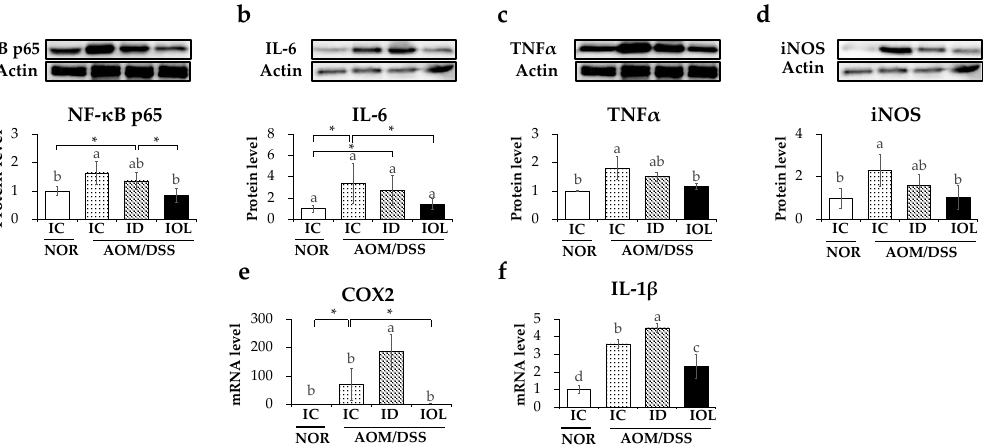
Figure 4. Iron overload downregulated the expression of genes related to AOM/DSS-induced in- flammation. Protein expression levels on NF- κB p65 ( a ), IL-6 ( b ), TNF α ( c ), iNOS ( d ), and mRNA expression level of COX2 ( e ), IL1b ( f ) related to inflammation released from large intestine tissue were measured. Data are expressed as Mean ± SD and SE. One-way ANOVA was used for the test of difference and Tukey for the post-hoc test. Different letters above the value indicate statistical significance. Student’s t -test was used to test the difference between two groups and the asterisk represents statistical significance (* p < 0.05). Abbreviations: NOR, normal; AOM/DSS, azoxymethane/dextran sodium sulfate; IC, iron control; ID, iron-deficient; IOL, iron overload; NF- κB, nuclear factor kappa -light-chain-enhancer of activated B cells; IL- 6, interleukin 6; TNFα, tumor necrosis factor alpha; iNOS, inducible nitric oxide synthase; COX2, cyclooxygenase-2; IL- 1β, inter- leukin 1 beta.